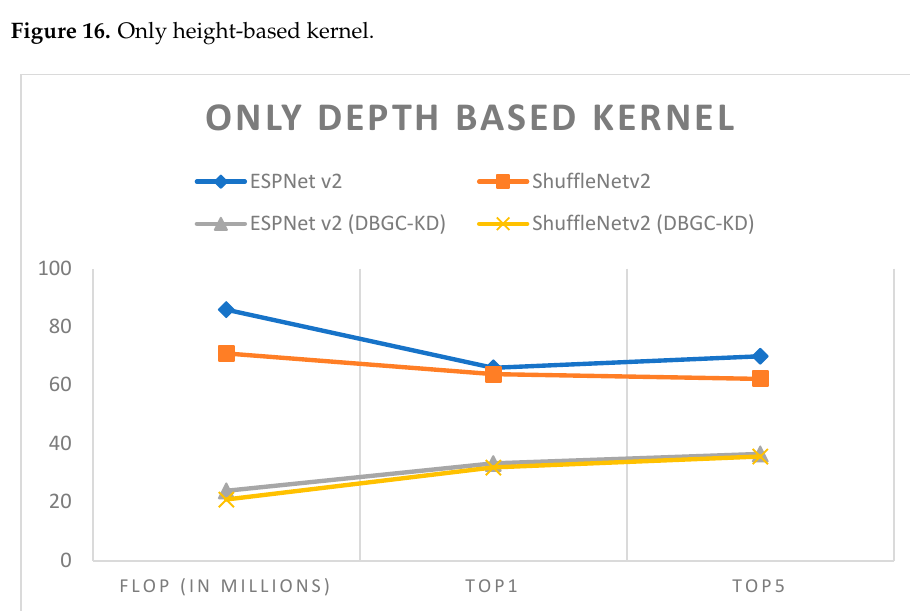
Figure 17. Only depth-based kernel.